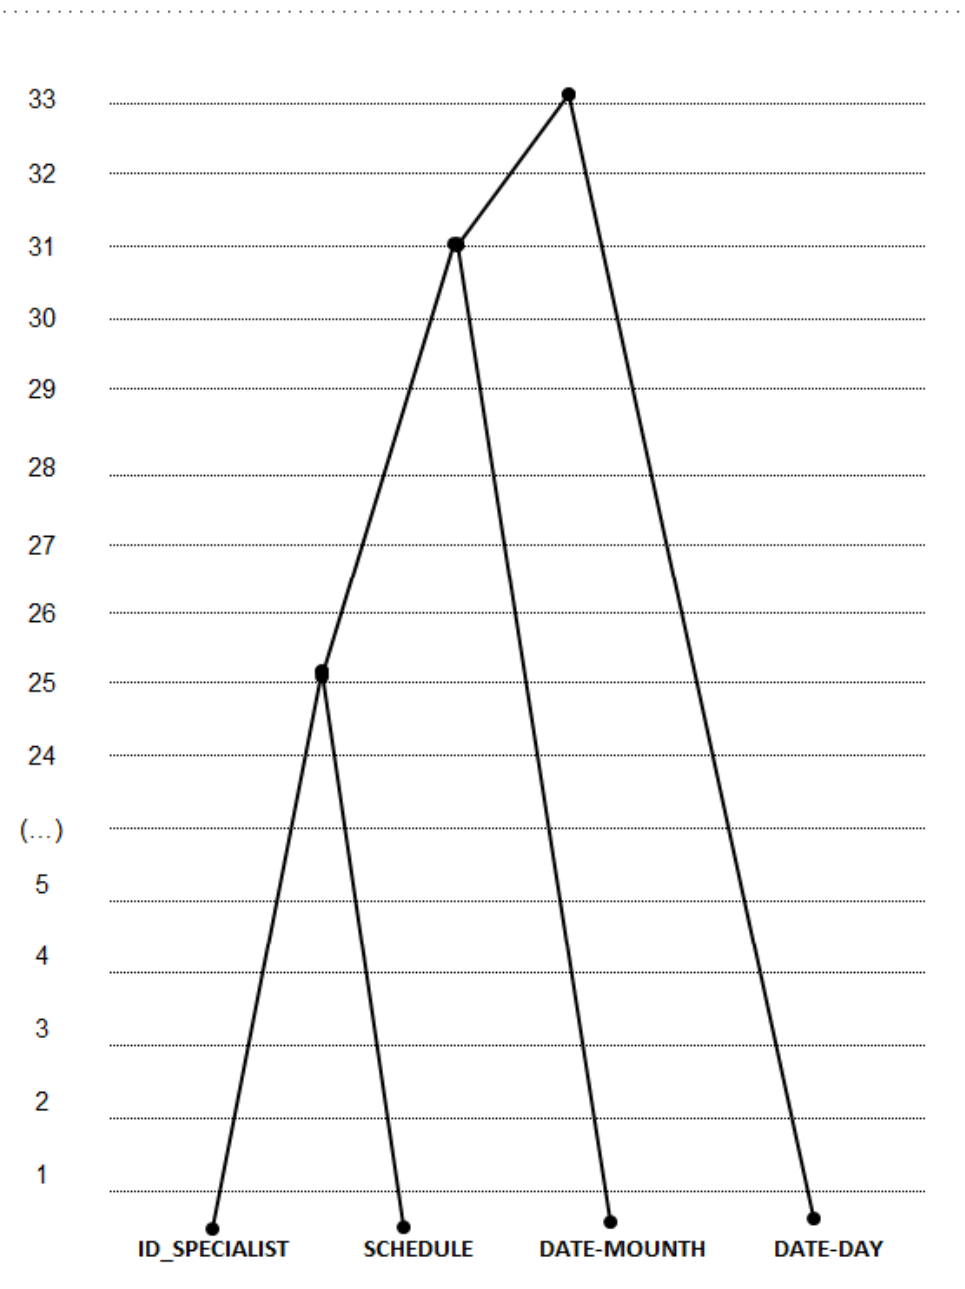
Figure 2: Ordered Tree of